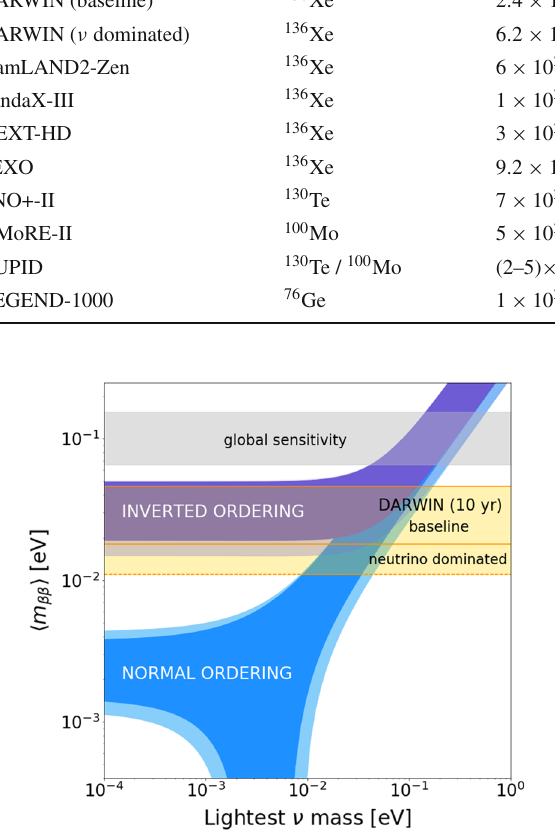
Fig. 9 Effective Majorana neutrino mass vs. lightest neutrino mass. The sensitivity reach after 50t × years of exposure is shown for the baseline and the optimistic neutrino dominated scenario. The horizon- tal bands stem from the range of nuclear matrix elements [36].